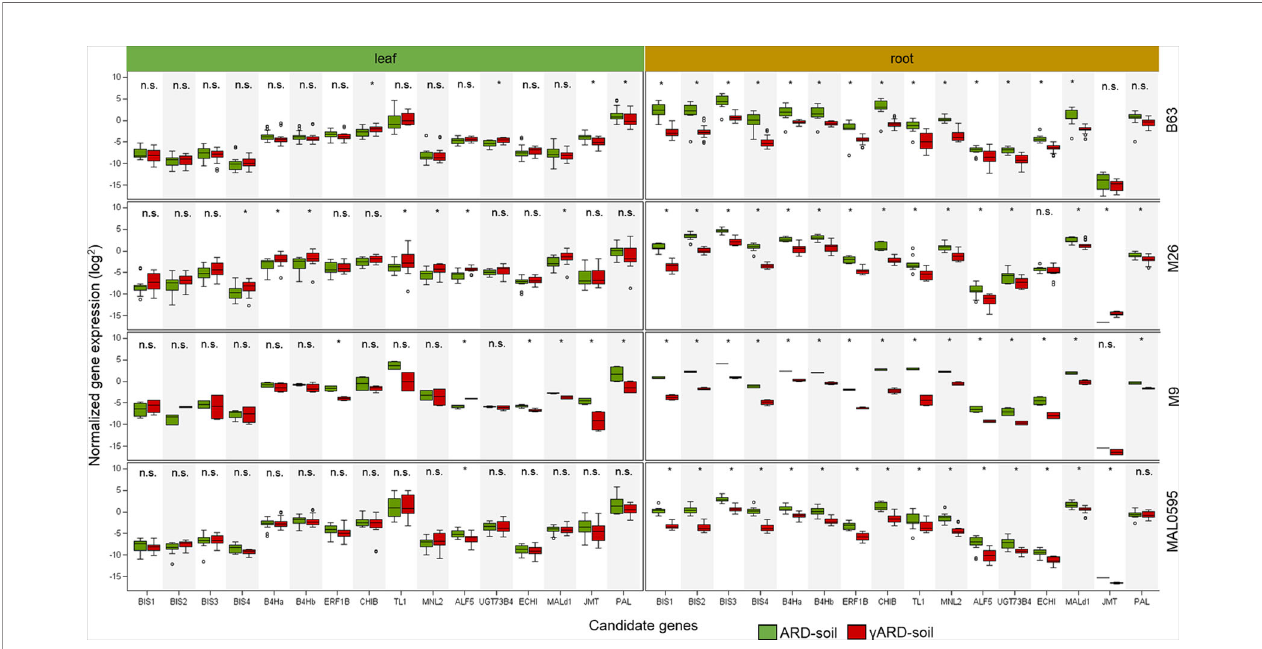
FIGURE 2 | Normalized gene expression values in leaf or root tissue of 16 highly upregulated candidate genes (CGs) in four different apple genotypes (B63, M26, M9 and MAL0595) grown in ARD and g ARD soil, respectively. The normalized gene expression values are average values for the both soil origins (Meckenheim and Heidgraben). Non-signi fi cant values are indicated as n.s.; signi fi cant values ( p < 0.05) are indicated with *. BIS1 , biphenyl synthase 1; BIS2 , biphenyl synthase 2, BIS3 , biphenyl synthase 3; BIS4 , biphenyl synthase 4; B4Ha , biphenyl 4-hydroxylase isoform a; B4Hb , biphenyl 4-hydroxylase isoform b; ERF1b , ethylene- responsive transcription factor 1B-like; CHIB, endochitinase EP3-like; TL1 , thaumatin-like protein 1a; MNL2 , putative mannosidase; ALF5 , multi antimicrobial extrusion protein; UGT73B4 , uridine diphosphate (UDP)-glycosyltransferase 73B4; ECHI , chitin-binding type 1; Mal d1 , major allergen Mal d1-like; JMT , jasmonate O-methyltransferase-like; PAL , phenylalanine